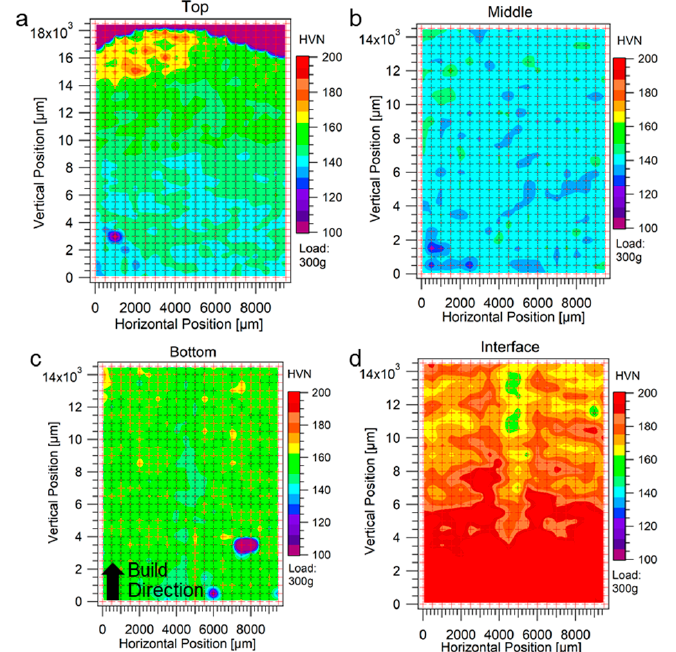
Figure 8. Hardness maps from different locations in the build height. ( a ) The last layer, top. ( b ) The middle of the build. ( c )Bottom of the build. ( d ) interface between base plate and beginning of the build. Images show the Z–Y plane (thickness) of the build.